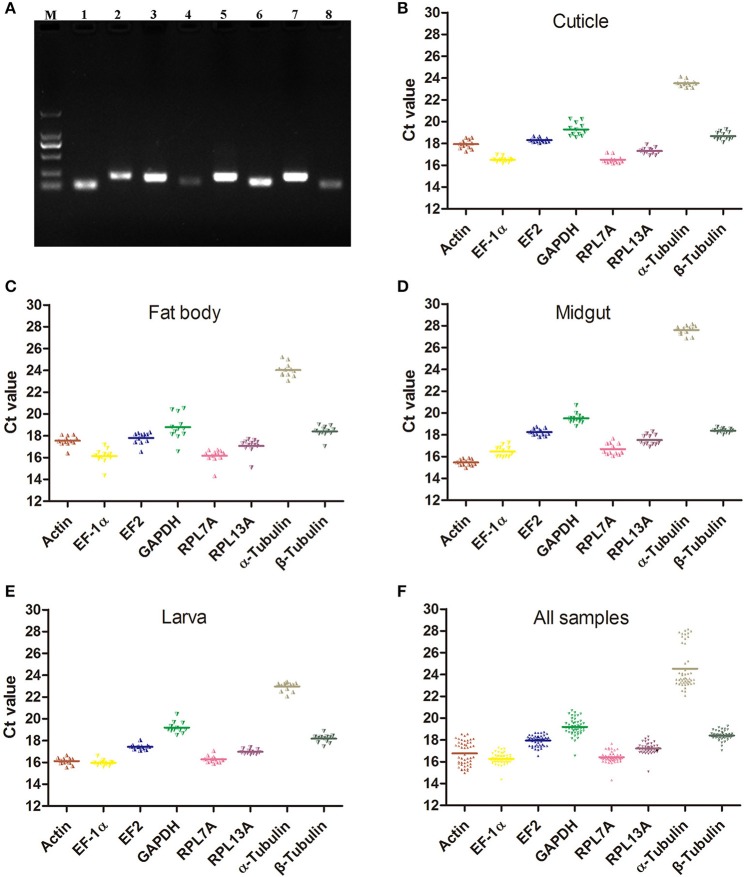
The expression profiles of the eight candidate reference genes. (A) Agarose gel of eight candidate reference genes PCR products amplified with the RT-qPCR primers. Lanes: M, Marker 2000, lane 1-8, Actin, EF-1α, EF2, GAPDH, RPL7A, RPL13A, α-Tubulin and β-Tubulin. (B–F) The expression profiles of the eight candidate reference genes in cuticle, fat body, midgut, larva, and all samples. (Actin), actin; (EF-1α), elongation factor 1alpha; (EF2), elongation factor 2; (GAPDH), glyceraldehyde 3-phosphate dehydrogenase; (RPL7A), ribosomal protein L7A; (RPL13A), ribosomal protein L13A; (α-Tubulin), alpha-tubulin; (β-Tubulin), beta-tubulin.